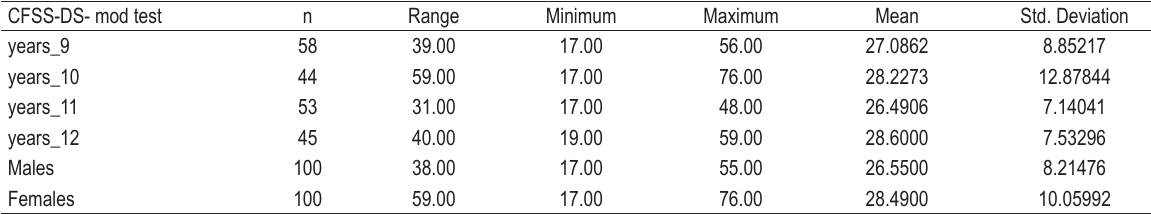
TABLE 2. Descriptive values of the results on the CFSS‑DS‑mode scale concerning the age and sex of the test groups